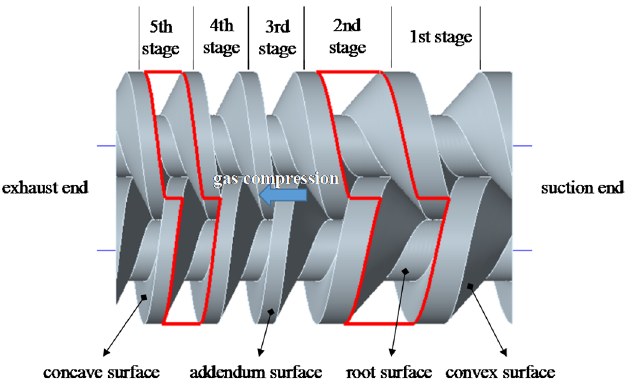
Fig. 2. Schematic diagram of theoretical variable-pitch screw